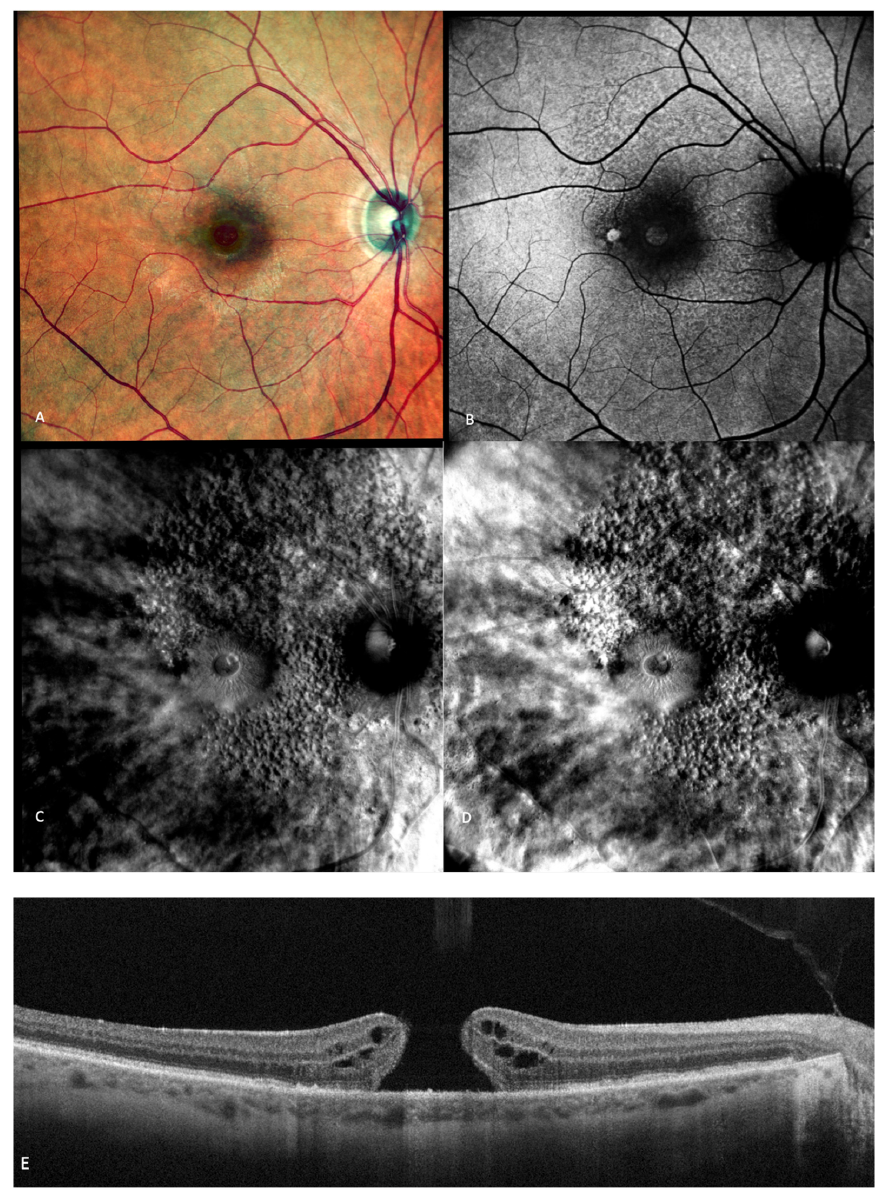
Figure 8. Multimodal imaging of a full-thickness macular hole (FTMH). ( A ) cSLO image showing a red central round area. ( B ) Green FAF showing central hyper-autofluorescence. ( C , D ) Retromode DR and DR showing a “single round excavation” [55] and the cystoid spaces around it. ( E ) SD-OCT where the large FTMH is visible.